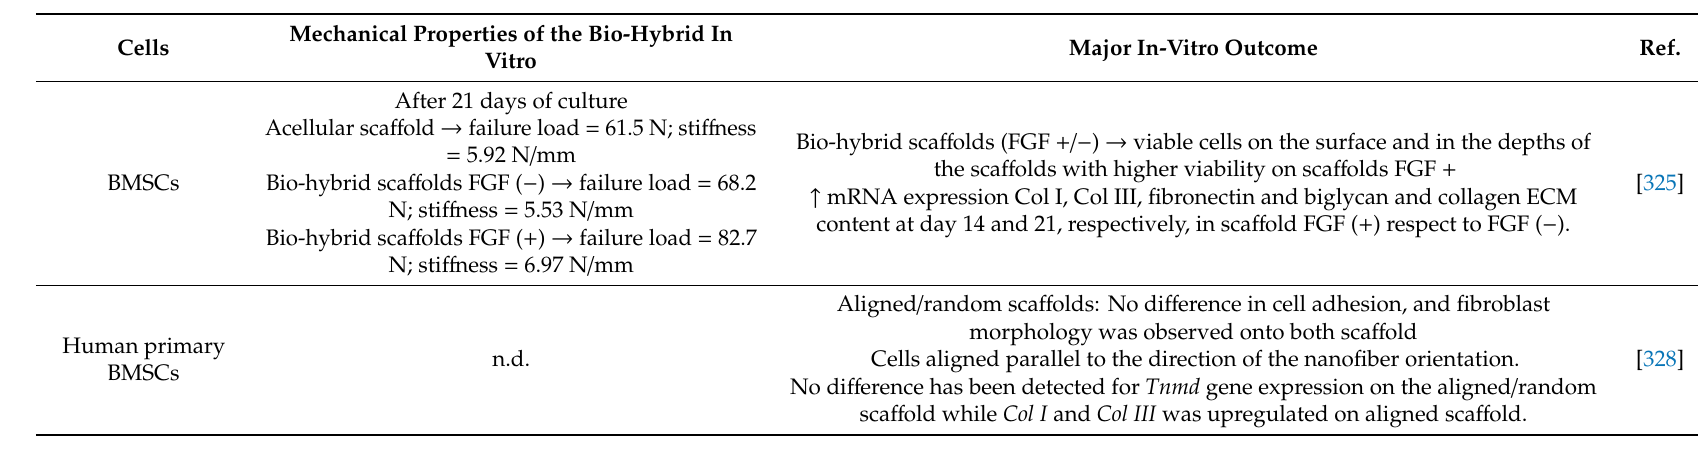
Table 2. In vitro assessment of teno-inductive properties of sca ff olds on stem